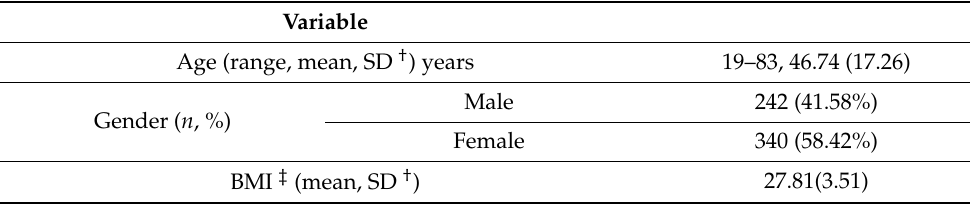
Table 1. Demographics and clinical characteristics of the study